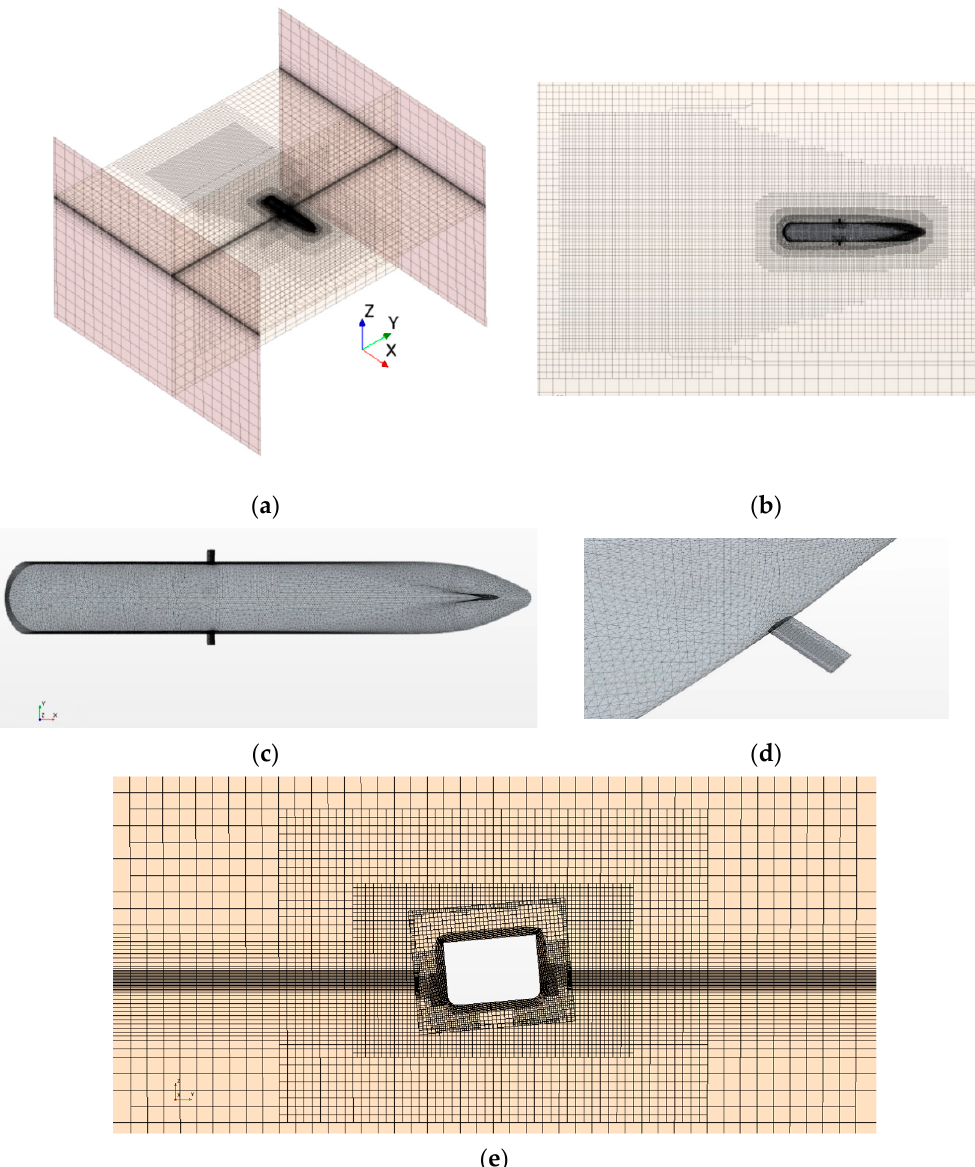
Figure 7. Grids around the hull and fins. ( a ) Meshing of the virtual tank area. ( b ) Grid blocks for capturing Kelvin wave. ( c ) Hull surface grids. ( d ) Fin grids. ( e ) Overset grids.